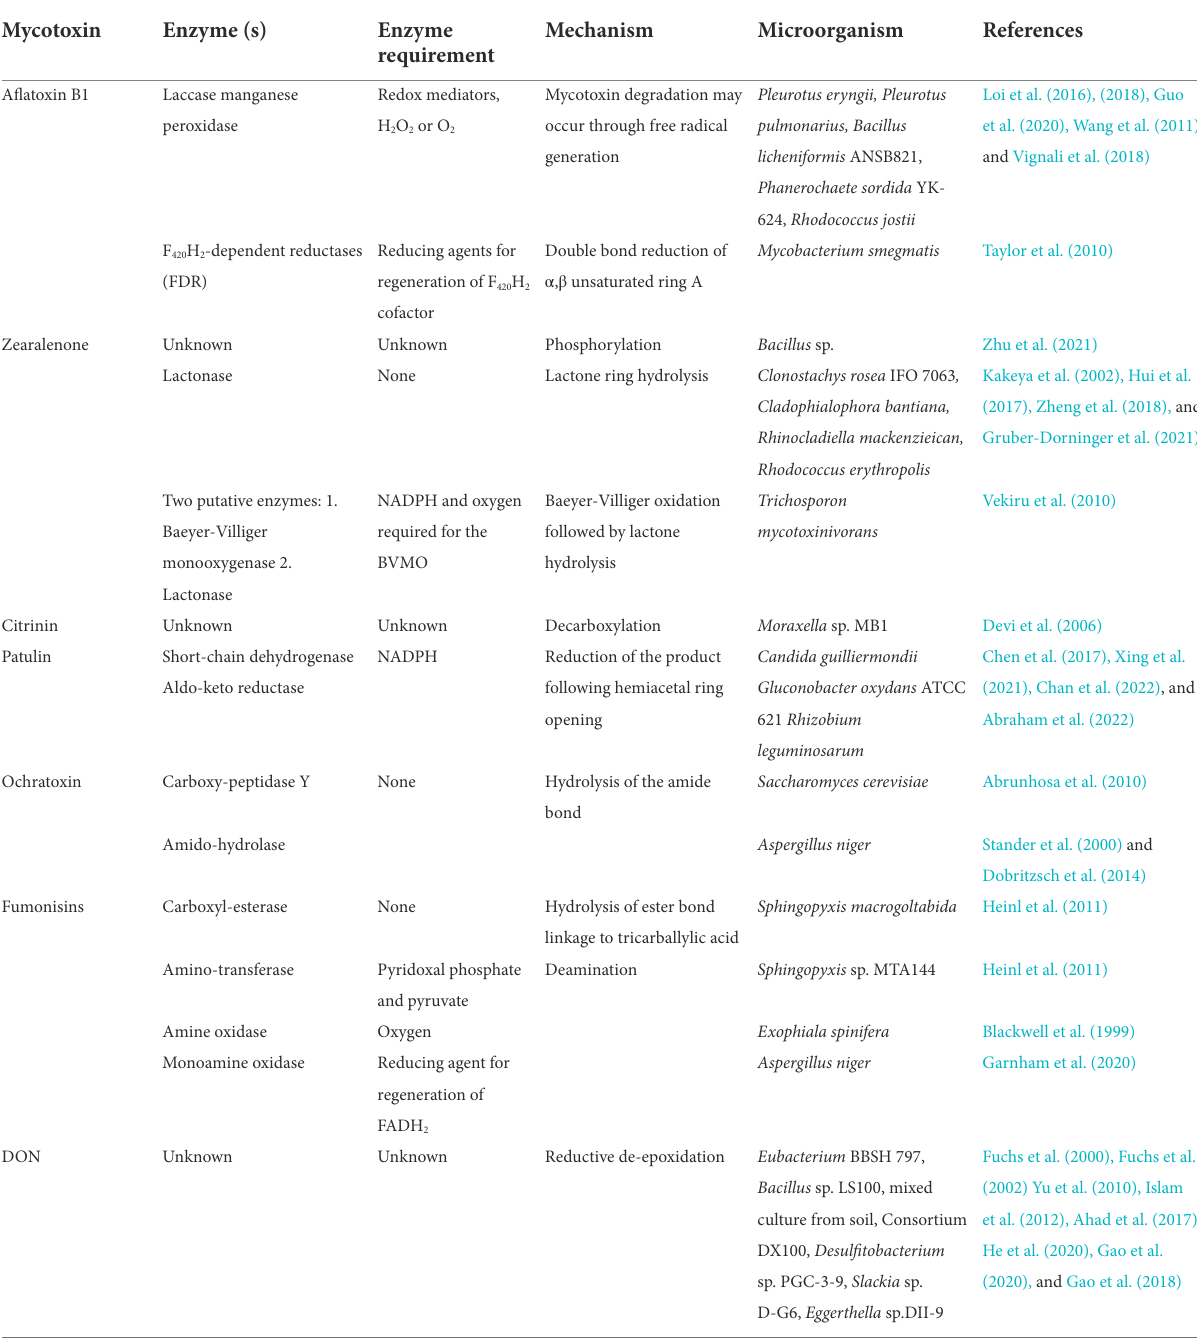
TABLE 2 Summary of isolated and putative enzymes involved in mycotoxin